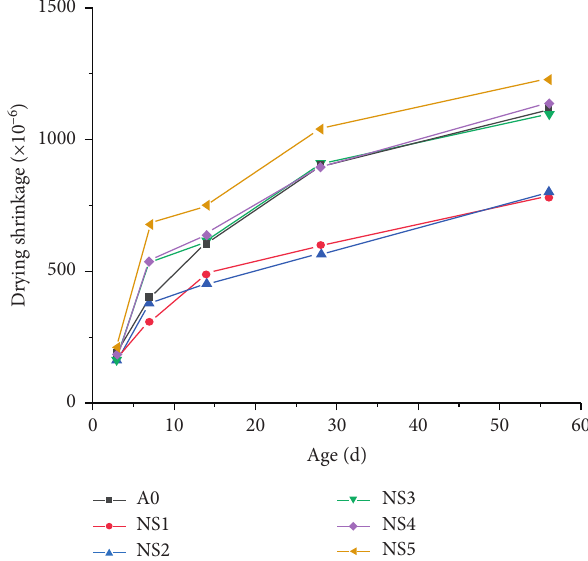
Figure 5: Effects of NS on alkali-activated mortar drying